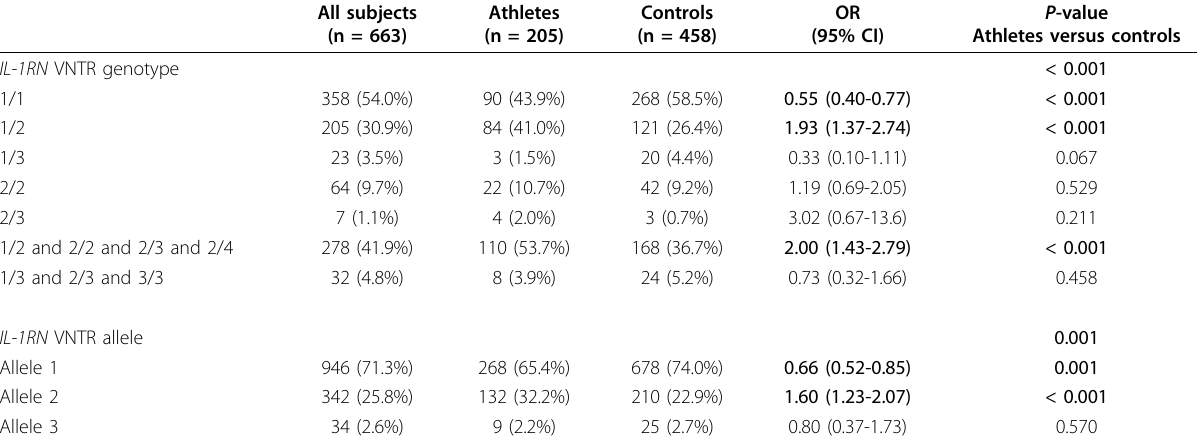
Table 4 Genotype frequencies of IL-1RN VNTR, comparison of 205 athletes and 458 non-athlete